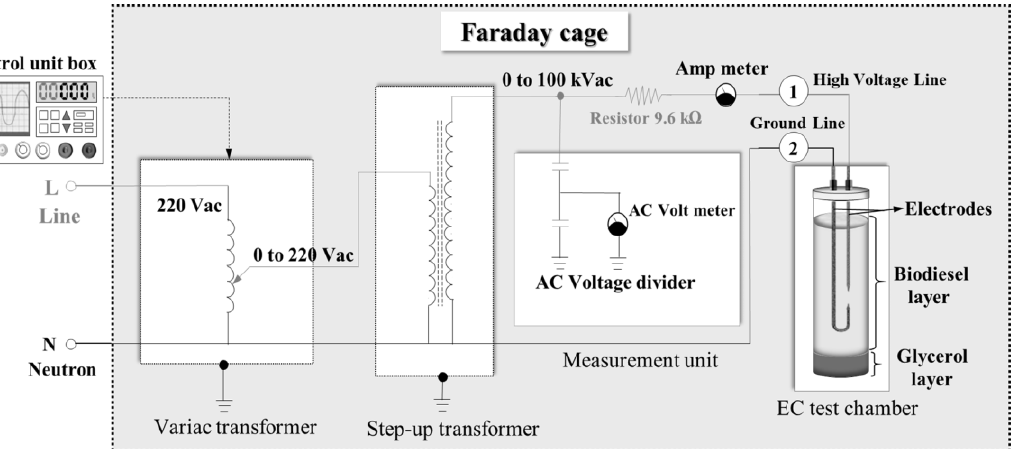
Figure 7. Schematic diagram of EDS setup with AC electrical current at high voltage for glycerol separation from biodiesel.